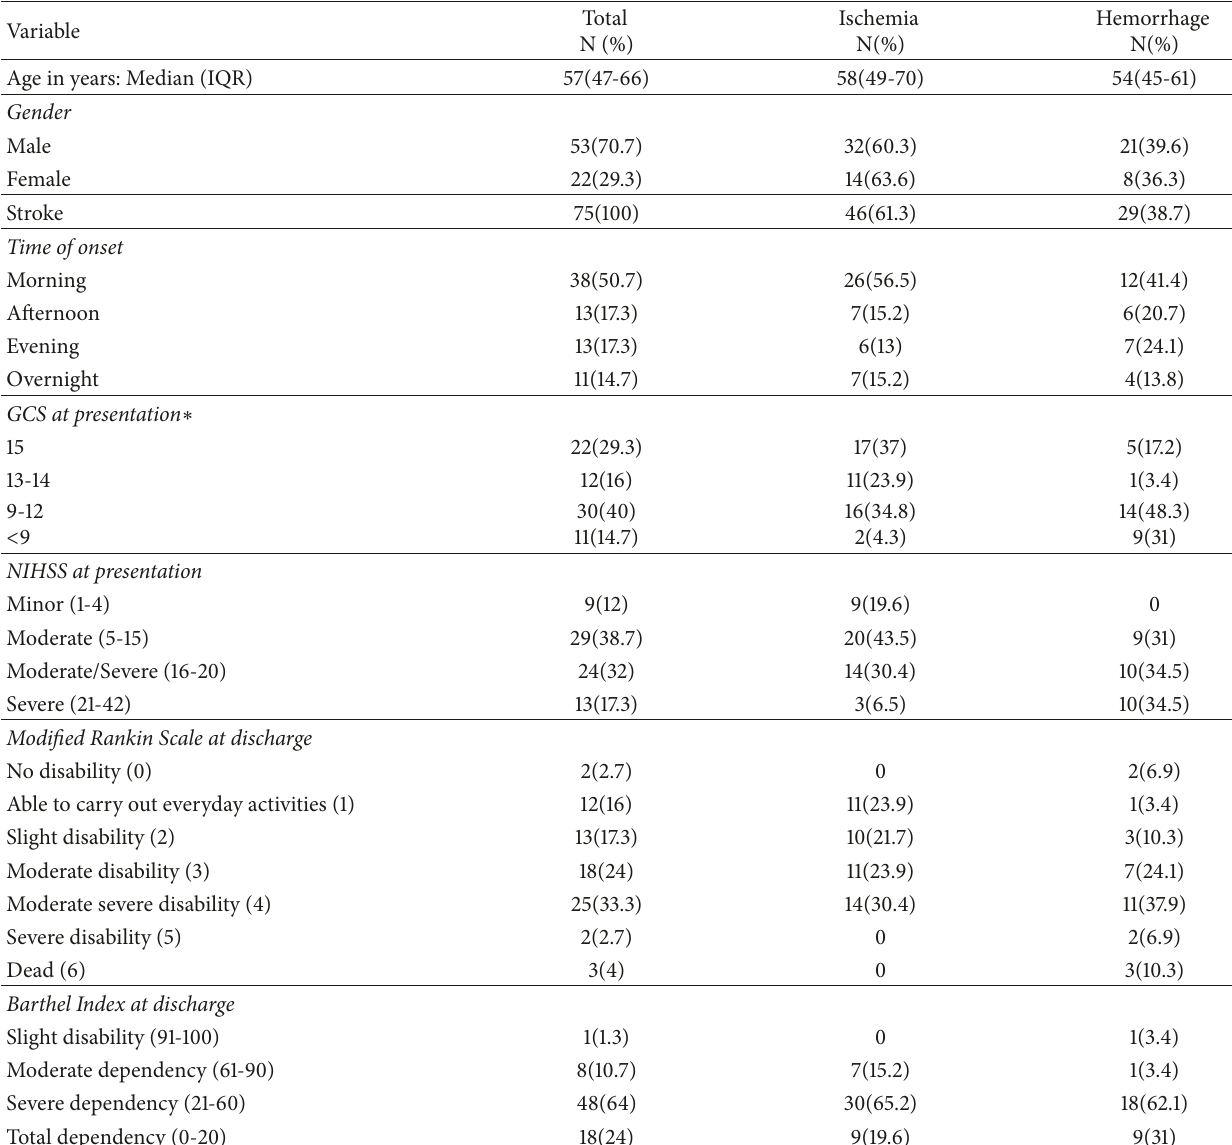
Table 1: Demographic and clinical characteristics of patients with acute stroke on presentation to Emergency Department and on discharge from the Aga Khan University Hospital, Karachi, Pakistan, January 01 to December 31,